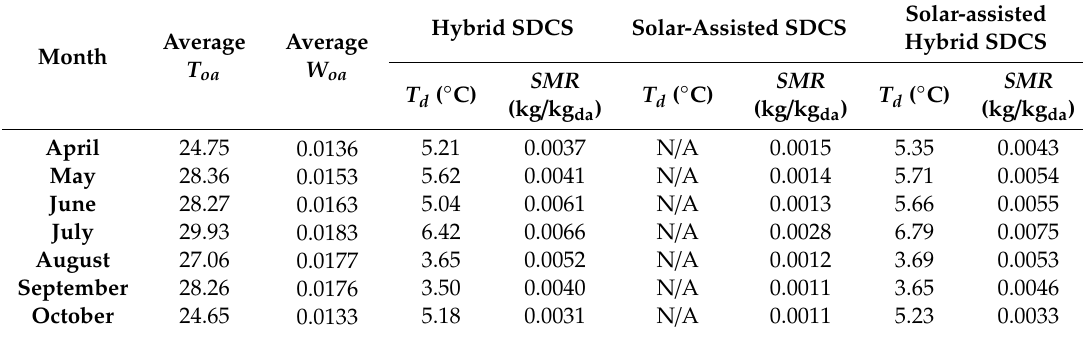
Table 2. Comparison of T d and specific moisture removal ( SMR ) for di ff erent system configurations.